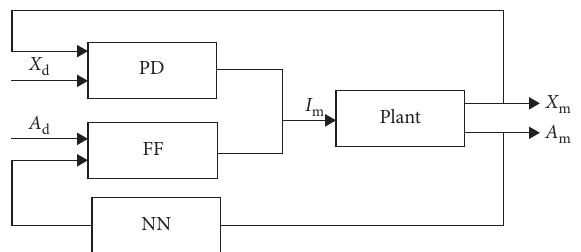
Figure 6: Schematic diagram of the proposed NN-PDFF controller.